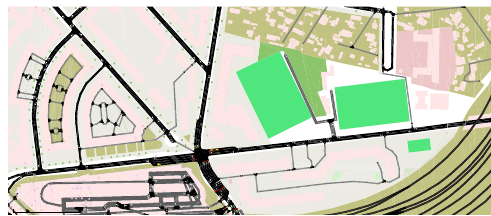
Figure 6. SUMO road infrastructure map with collisions of